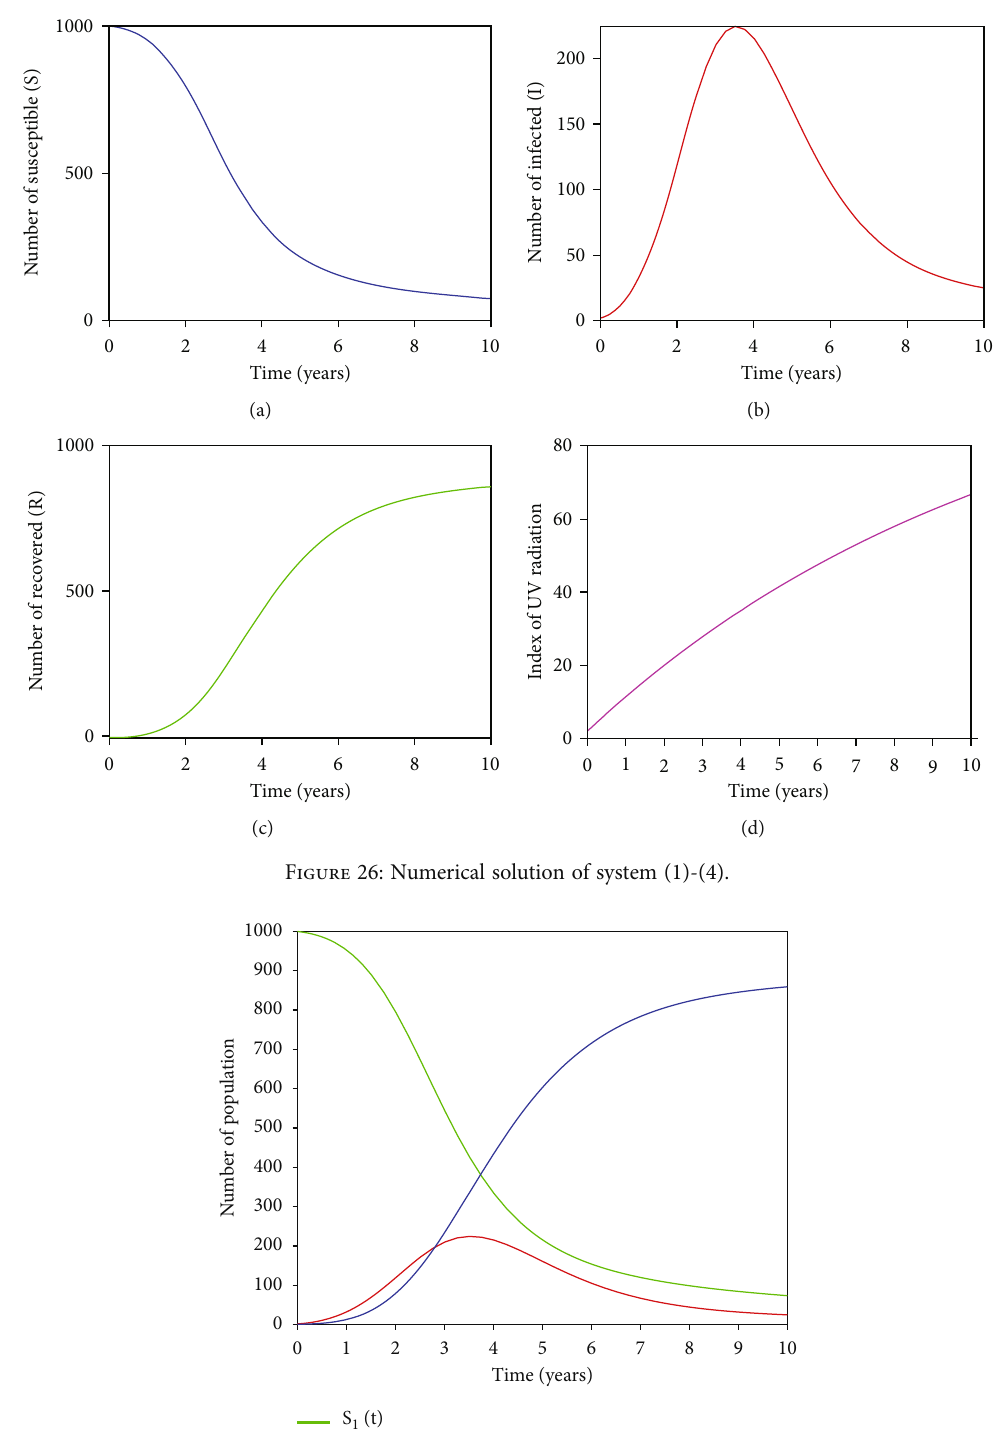
Figure 27: Solution trajectory of susceptible, infected and recovered individual of system